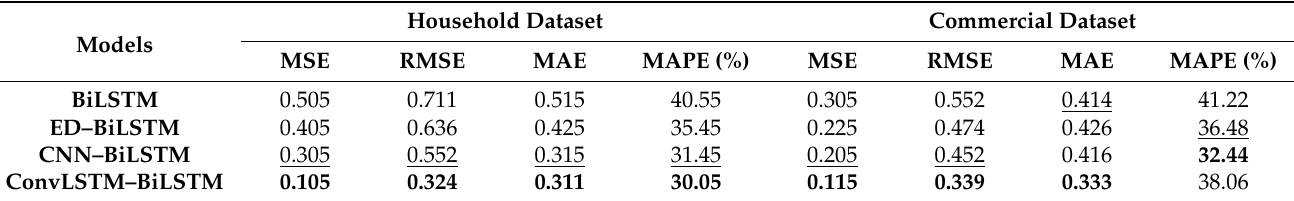
Table 4. Performance of the proposed models on the hourly resolution.